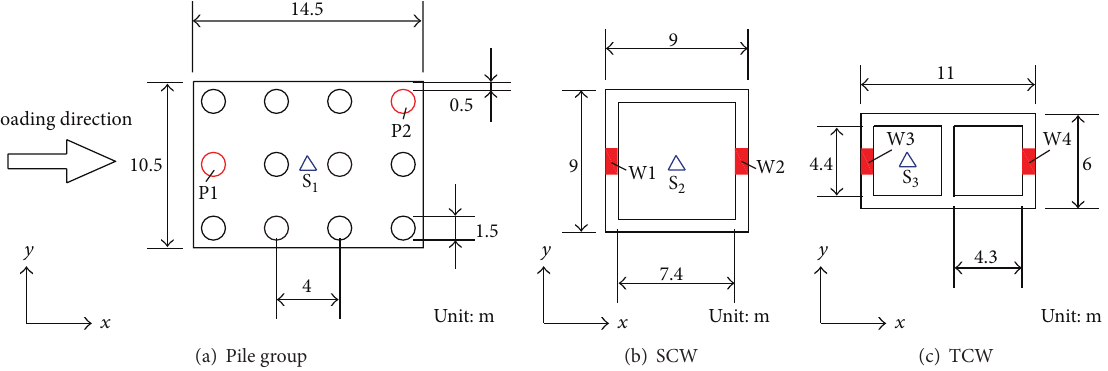
Figure 4: Cross-sectional dimensions and monitoring points of three models.